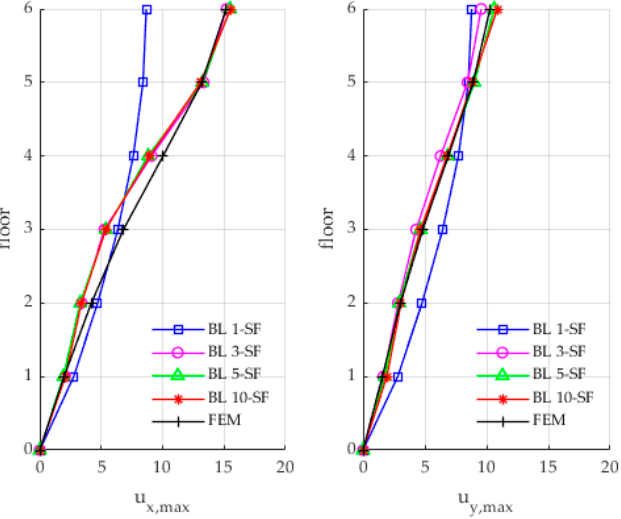
Figure 21. Six-storey benchmark. Maxima floor displacements in the L’Aquila earthquake for a different number of shape functions adopted in the Rayleigh–Ritz discretization. number of shape functions adopted in the Rayleigh–Ritz